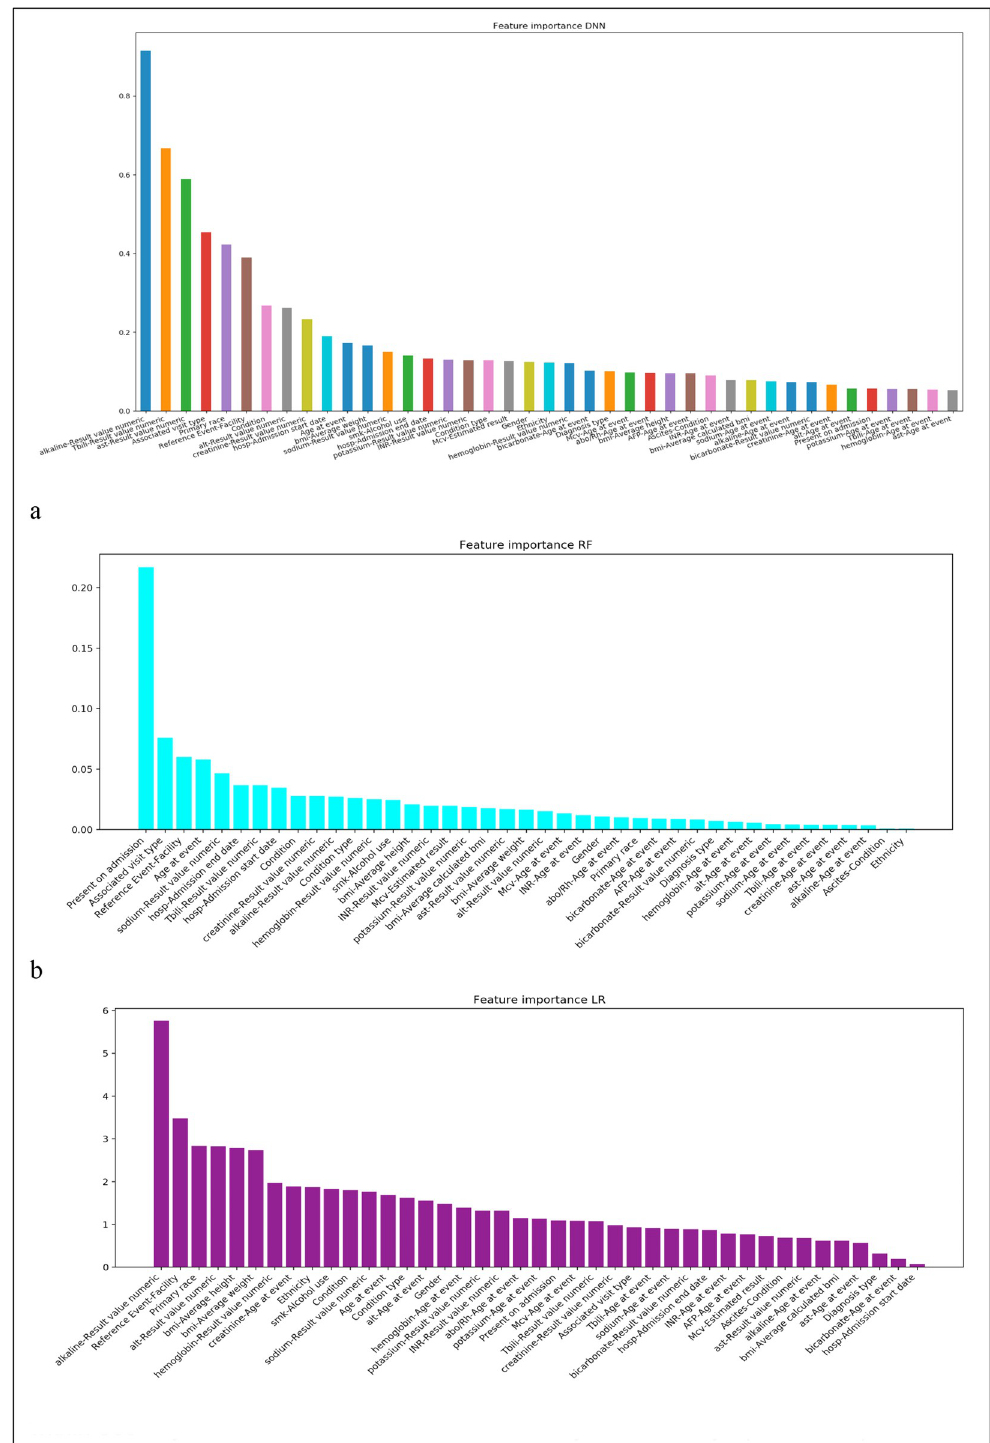
Fig 3. Feature importance by DNN (a), RF (b) and LR (c). This is the case for mortality within 365 days. We have similar results for 180 days and 90 days (not shown).